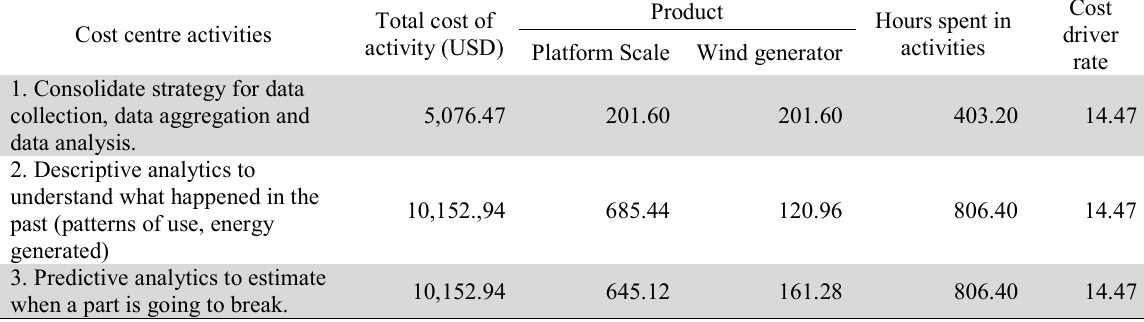
Cost driver rate estimation based on hours allocated to each